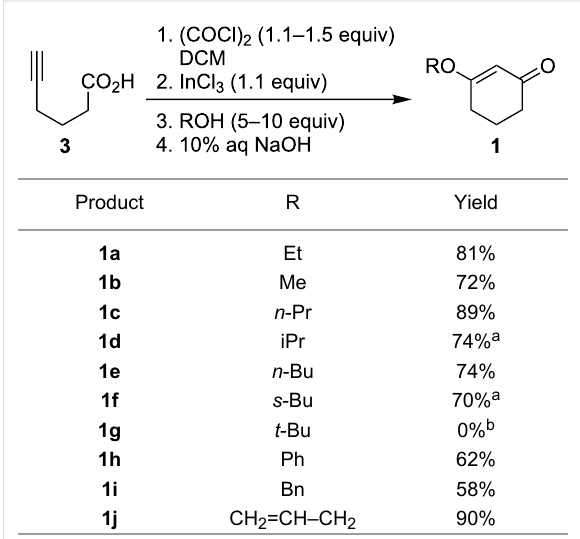
Table 2: One-pot procedure for the cyclization of 5-hexynoyc acid to